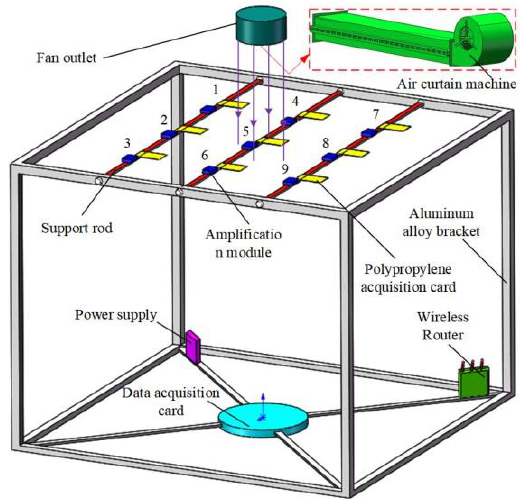
Figure 7. Wind speed test calibration device in lab.